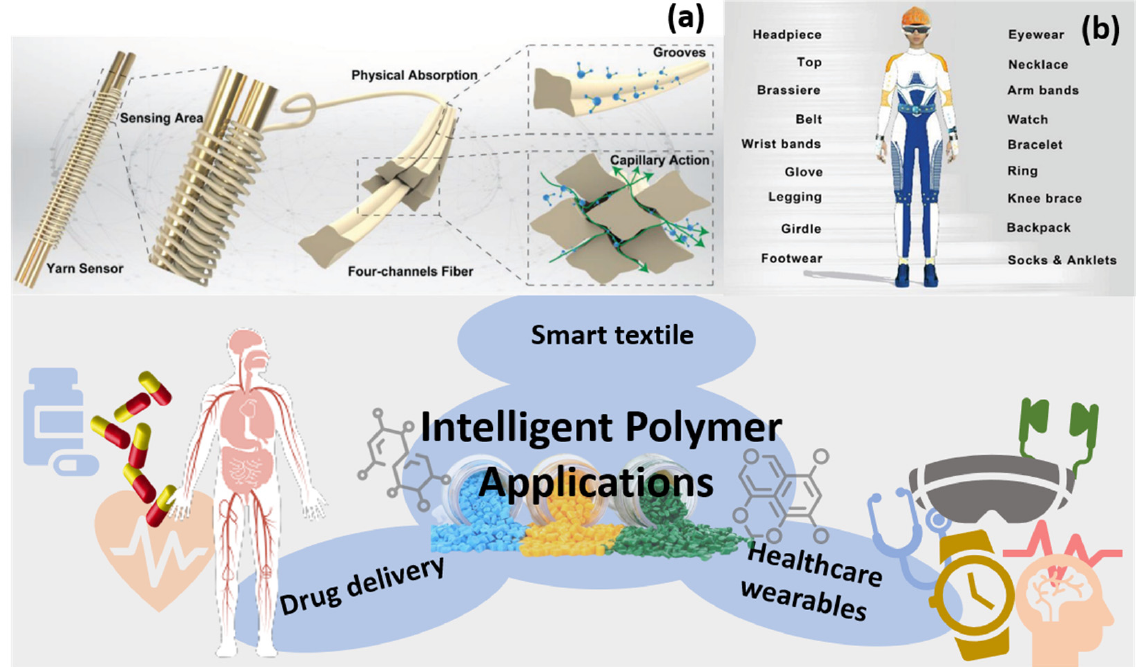
Figure 7. Trending topics in intelligent polymer applications: smart textile, drug delivery and healthcare wearables; ( a ) full-textile wireless flexible humidity sensor for human physiological monitoring [114]; ( b ) smart textile assemblies in wearable microelectronic systems [136].